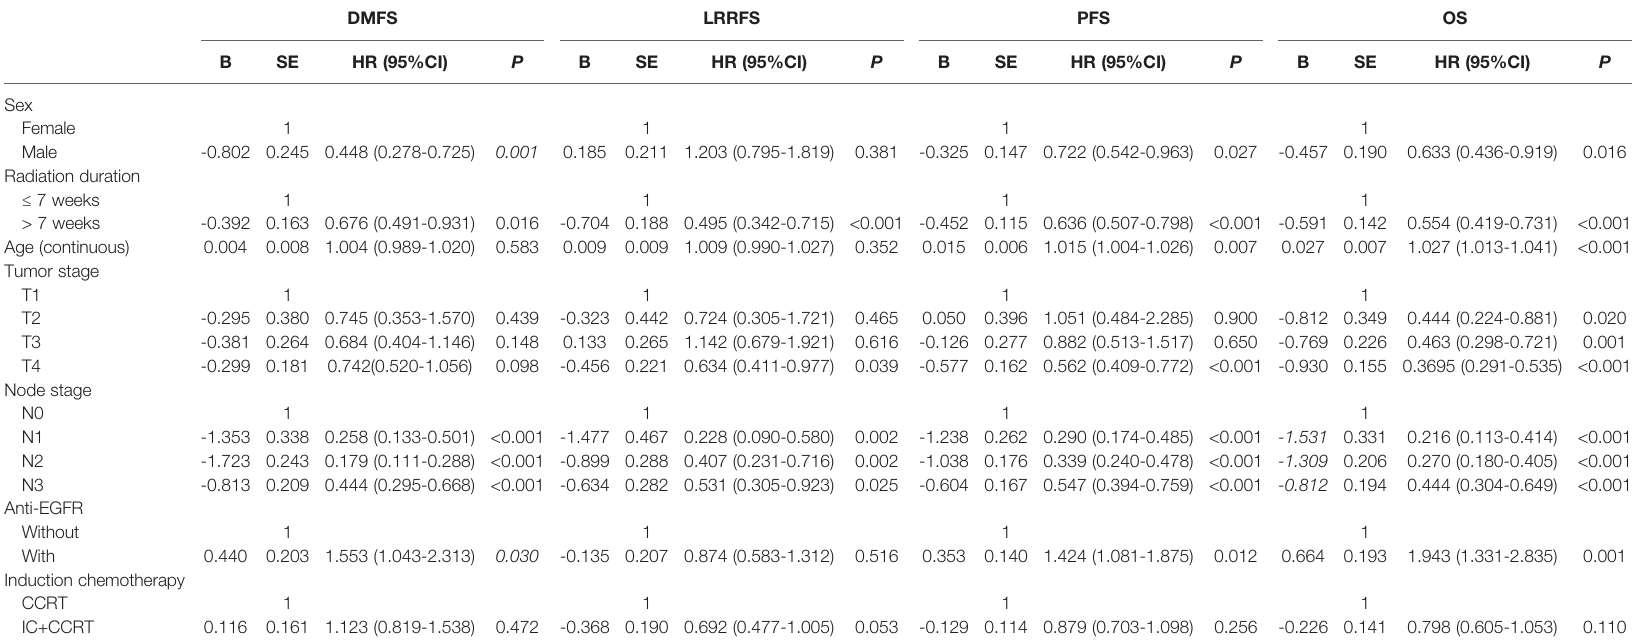
TABLE 2 | Prognostic factors associated with overall survival by univariate Cox regression model (N=1292).